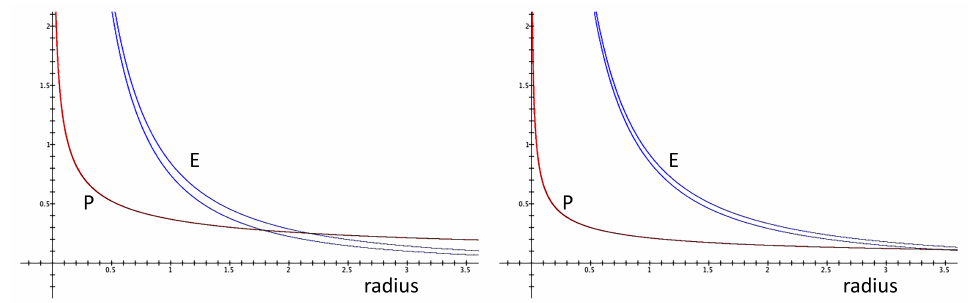
Figure 2. Kinetic energy density (blue curves) and gas pressure P (red curves) derived from the implicit form Equation (8) in Case B, for L / L 0 = 1.0. The left panel has a Mach number M 0 = 1.5, on the right M 0 = 2.0. The values of the adiabatic index are γ = 1 (isothermal equation of state, lower blue curves) and γ = 5/3 (adiabatic, upper blue